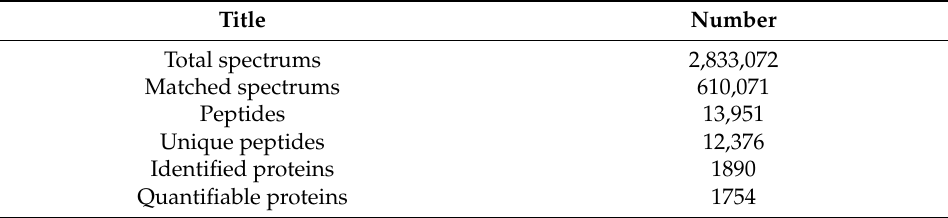
Figure 1. A workflow of the experiment based on serum proteomics. Table 1. Overview of protein